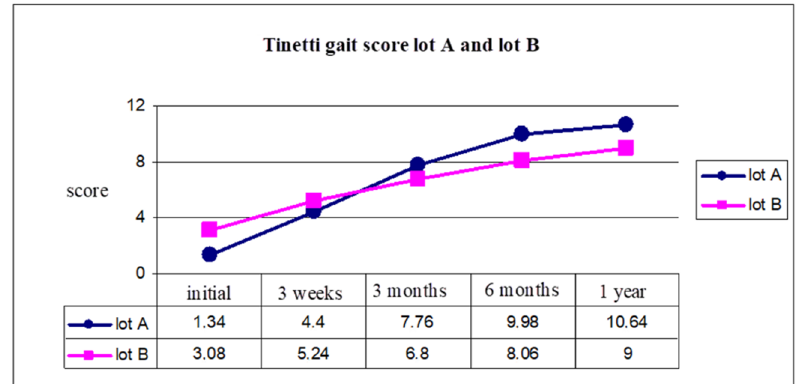
Figure 6. Tinetti gait score group A and group B.